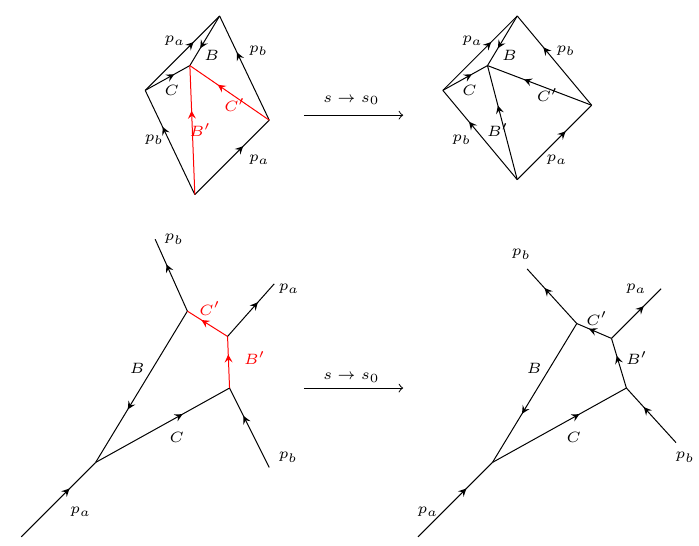
Figure 2 . Box diagram contributing to the pole (bottom row) and its dual description (top row). The loop integration variable l is chosen so that B 2 = m 2 general external kinematics (the left hand column) the momenta B 0 and C 0 are off-shell at this point; they become on-shell when s = s momenta are coloured black, off-shell